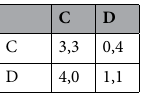
Table 1. Payoff matrix for both IPD